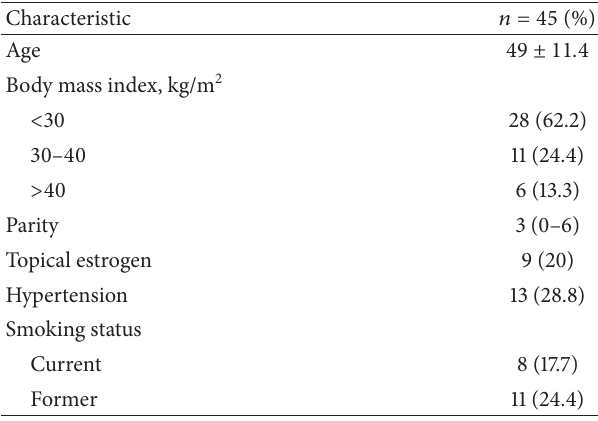
Table 1: Patient characteristics at baseline.